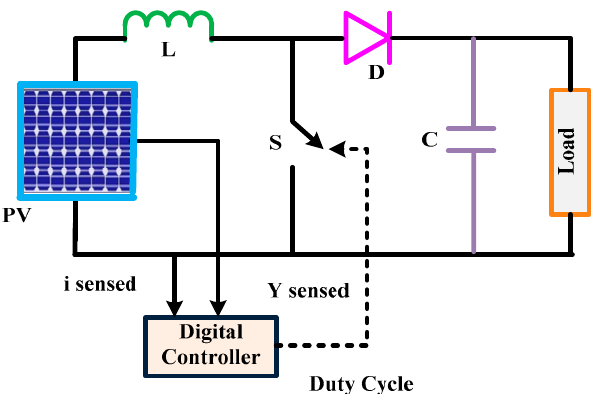
Figure 8. Block diagram of simulated system.